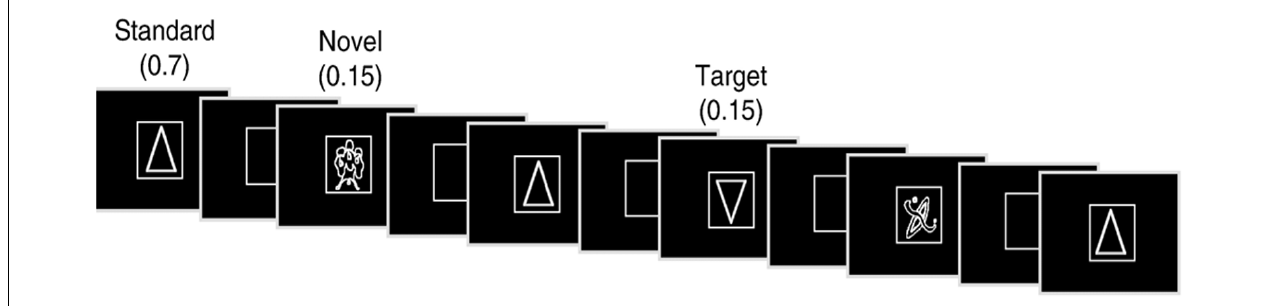
FIGURE 1 | Illustration of an experimental